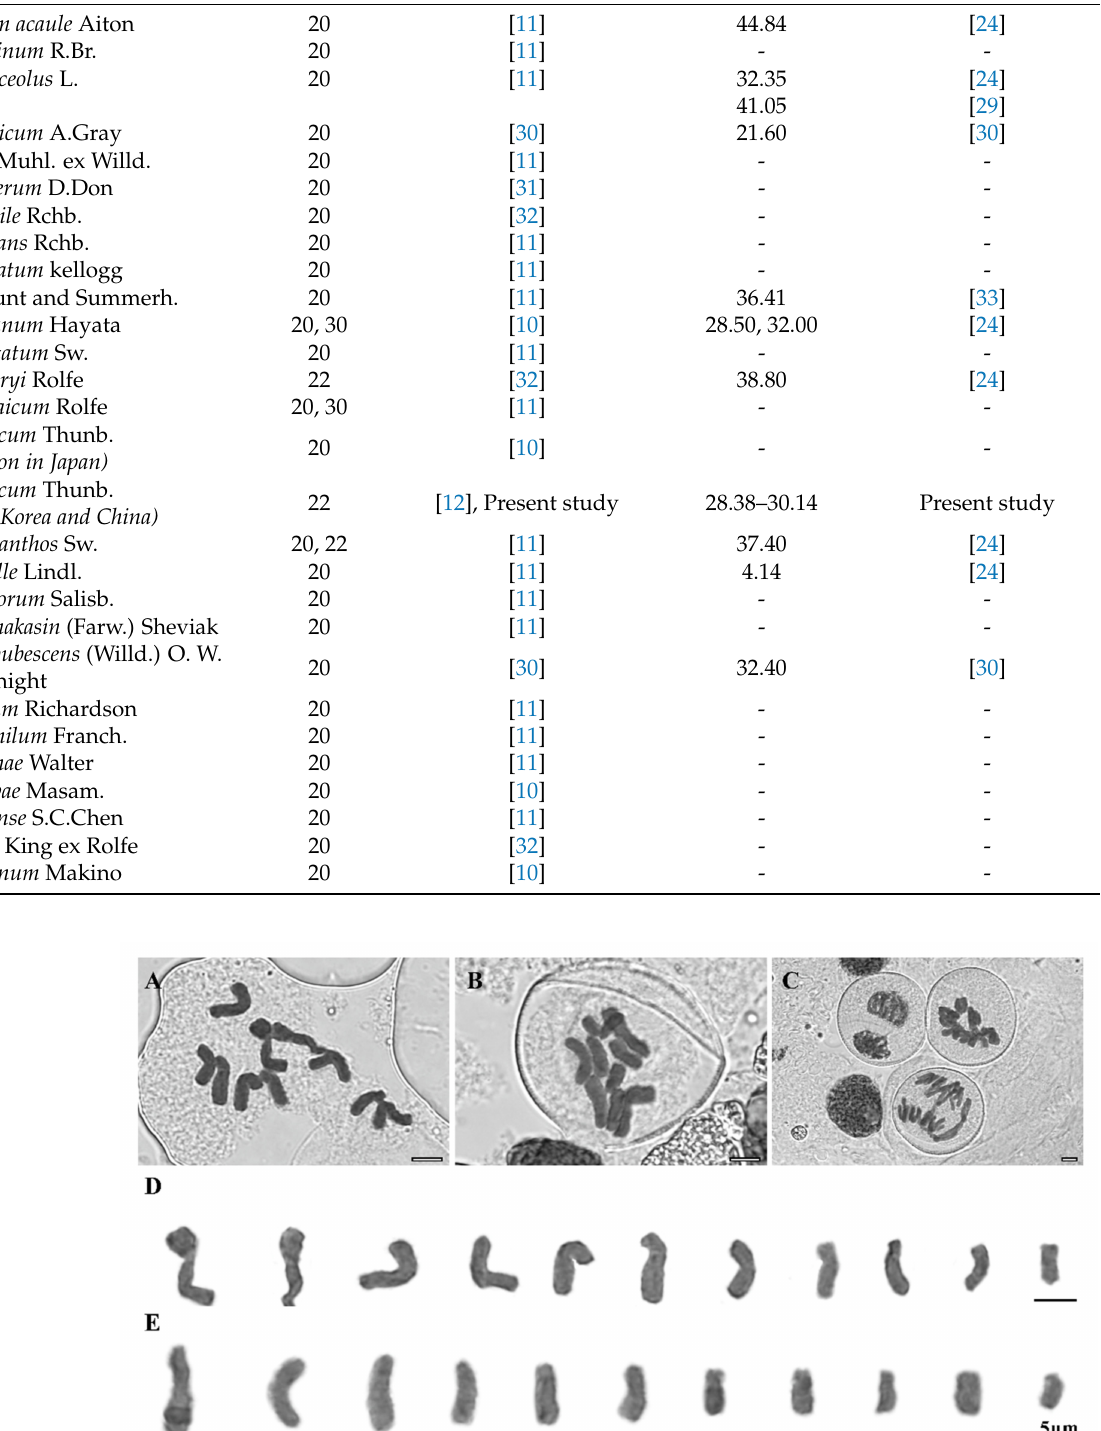
Table 2. New and previously published chromosome counting (2 n ) and genome size (1C/pg) data in the genus Cypripedium . Taxon 2 n